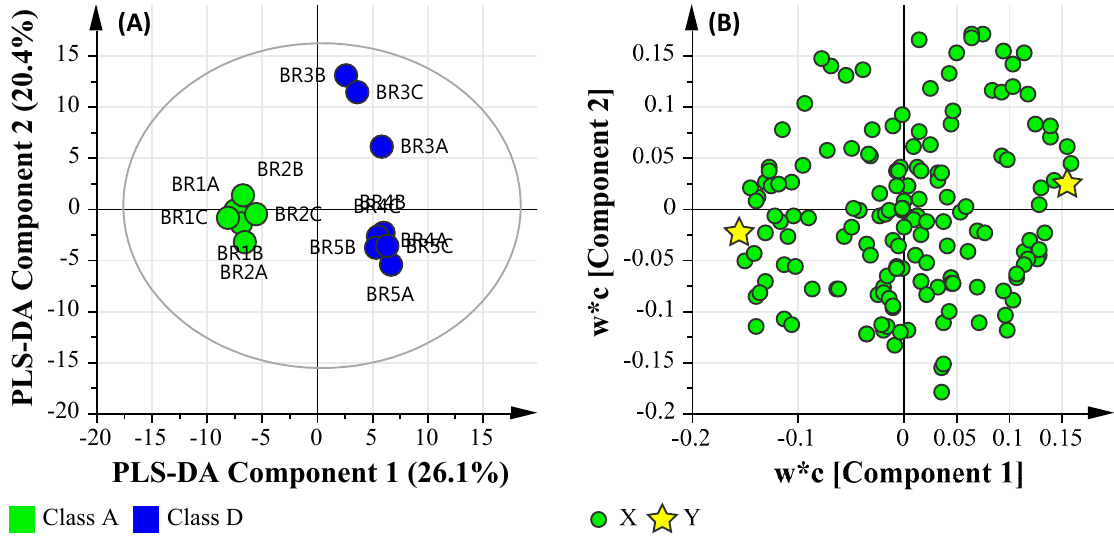
Figure 6. PLS-DA plot of the metadata and multi-omics datasets based the Microbial Water Quality Assessment Category class assessment. ( A ) PLS-DA Score Scatter plot; ( B ) PLS-DA Loading Scatter plot.